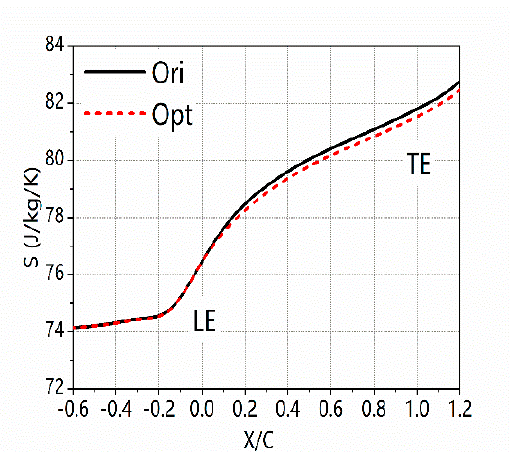
Figure 14. Chord-wise entropy rise of the second-stage rotor of the original and optimized compressors.